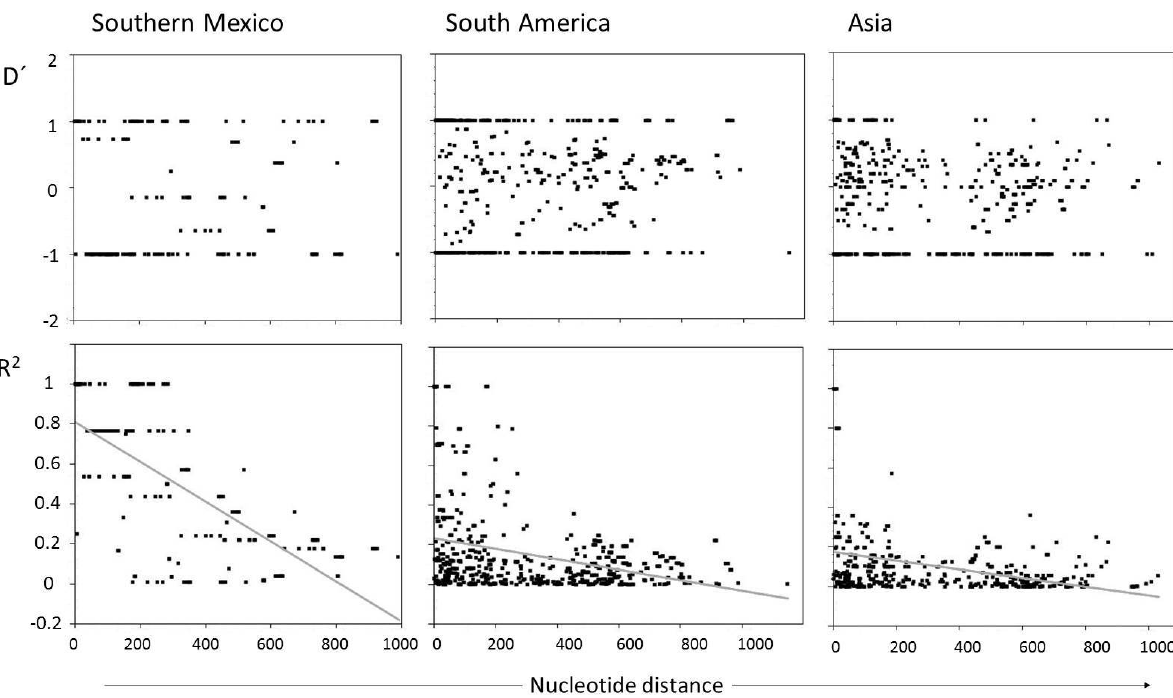
Figure 4. Linkage disequilibrium analysis of the P. vivax cyrpa gene. Parasites from Southern Mexico and other regions. The D’ and R 2 indexes were calculated using only informative sites. For parasites from Southern Mexico, the regression line emerges at an R 2 value of ~0.8 and decreases steadily whereas for the other parasites, the line initiates at ~0.2 and decays slowly. Most significant values were for nucleotide distances < 300 bp. Exon-1, 1–605nt; intron, 606–828; and exon-2 of 478nt, 823–1306. No gaps were